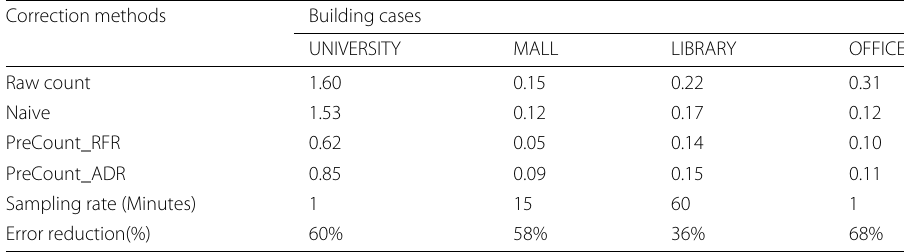
Table 3 A table comparing the evaluation results for all building cases Correction methods Building cases UNIVERSITY MALL LIBRARY OFFICE